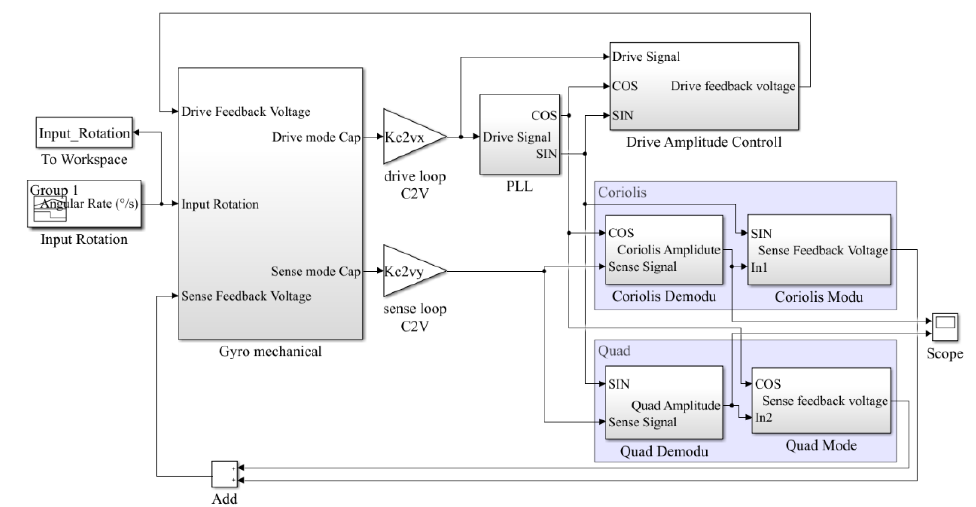
Figure 6. Gyroscope Simulink model.